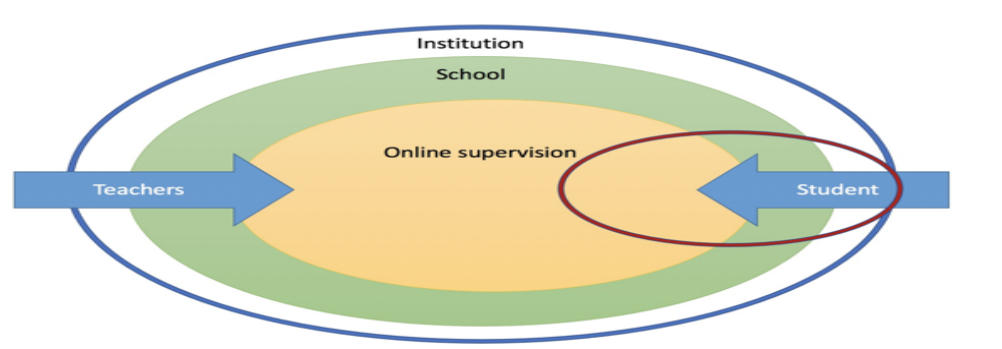
Figure 2: Illustration of the focus of this